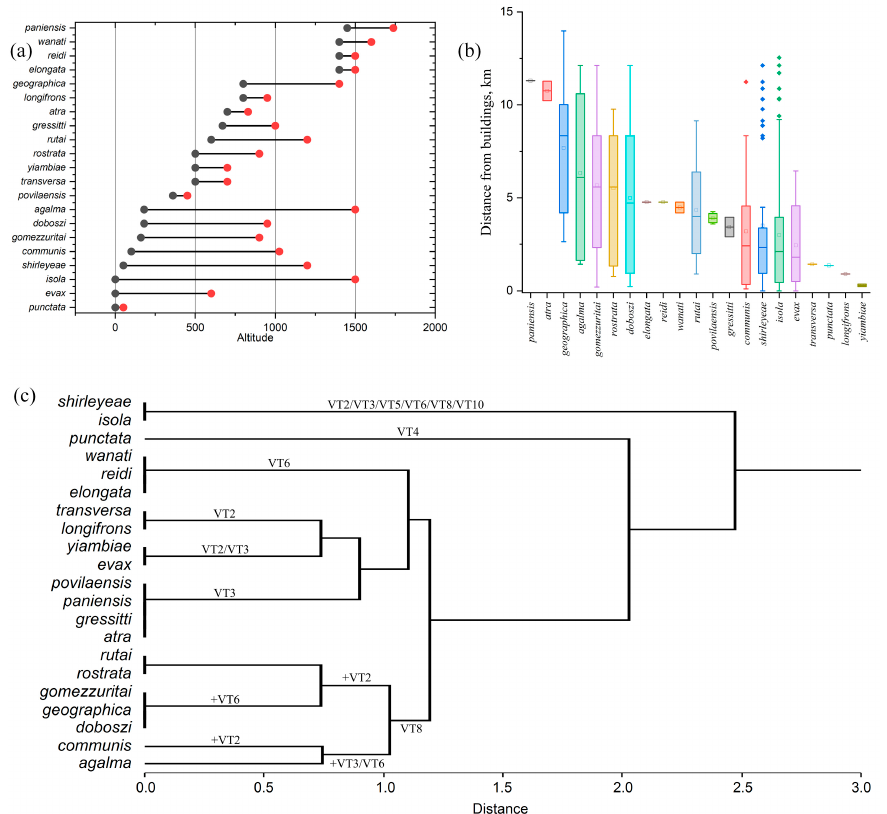
Figure 2. ( a ) Altitudinal ranges and ( b ) sampling distances from built-up areas for the New Caledonian Arsipoda species. ( c ) Dendrogram obtained from cluster analysis performed over Arsipoda species and their vegetation type preference.